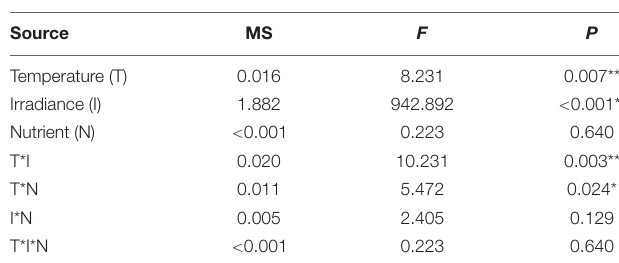
TABLE 1 | Results of three-way ANOVA on the effects of temperature, irradiance, and nutrient enrichment on maximum PSII efficiency ( F v / F m ) of E. bicyclis juvenile